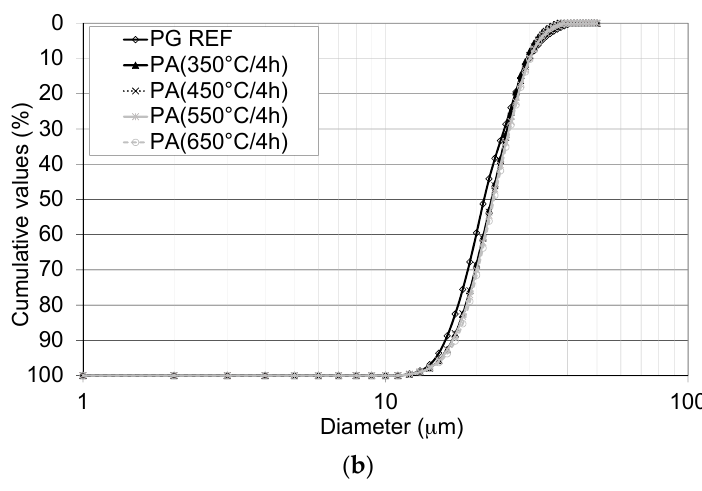
Figure 1. Particle size analysis of calcium sulfate samples studied: phosphogypsum (PG REF), β -hemihydrate, and phosphoanhydrite (PA) obtained from the calcination of gypsum at temperatures of 350 °C, 450 °C, 550 °C, and 650 °C during 2 h ( a ) and 4 h ( b ). Table 5. Particle size (D 10 and D 50 ).